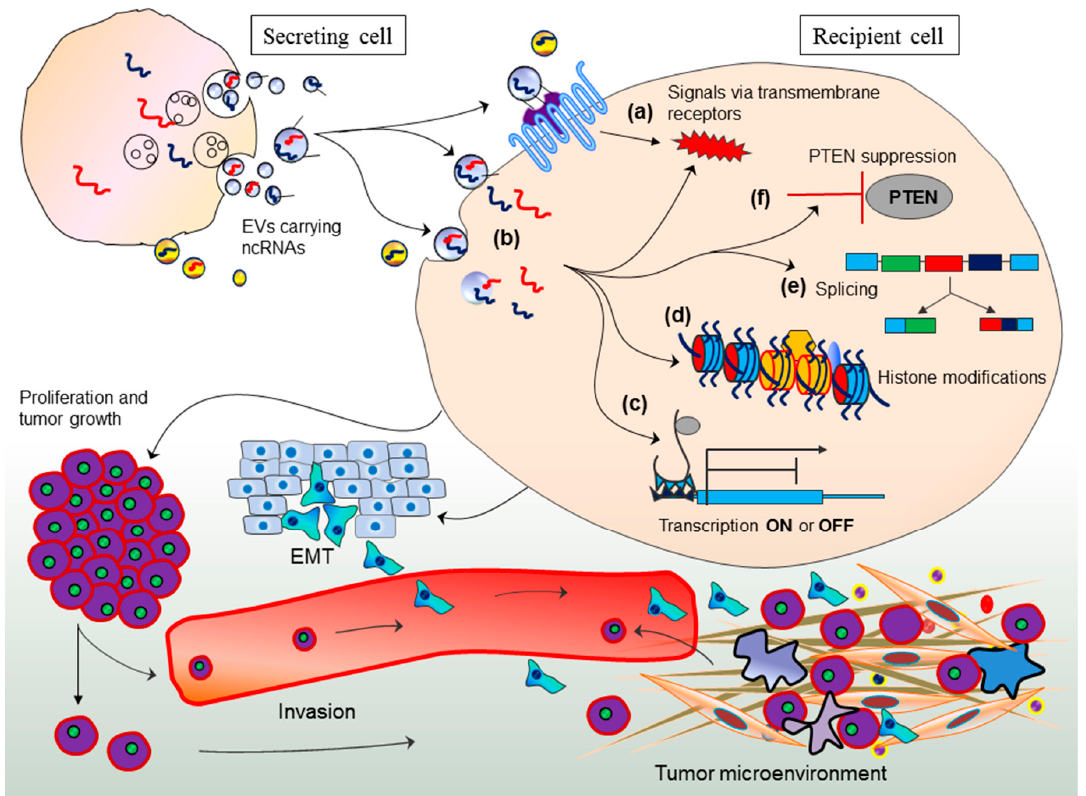
Figure 1. EV ‐ mediated ncRNA transport and mechanism of trans ‐ regulation, genomic instability and tumor progression. Tumor cell ‐ derived EVs carrying ncRNAs are transported to recipient cells and may trigger cellular responses either by ( a ) direct receptor mediated interactions; or ( b ) could be endocytosed, followed by the release of ncRNAs in cytoplasm; ( c ) The ncRNAs may find their target mRNAs in recipient cell cytoplasm and may modulate gene expression either by repressing or activating the target genes; ( d ) The ncRNAs might recruit methylation machinery and may contribute to histone modifications; ( e ) EV ‐ mediated delivery of splicing components may contribute to